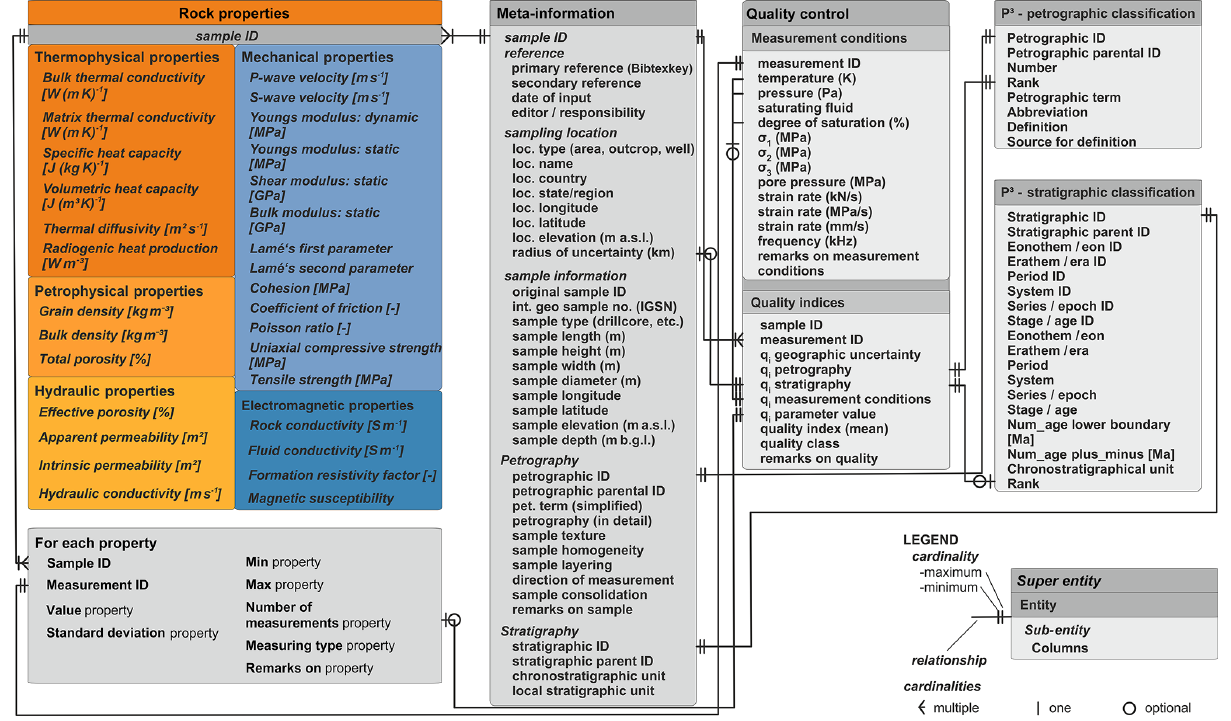
Figure B1. Relational structure of the PetroPhysical Property Database P 3 as an entity-relation diagram (ERD). Sub-entities are linked through the sample ID, the petrographic ID or stratigraphic